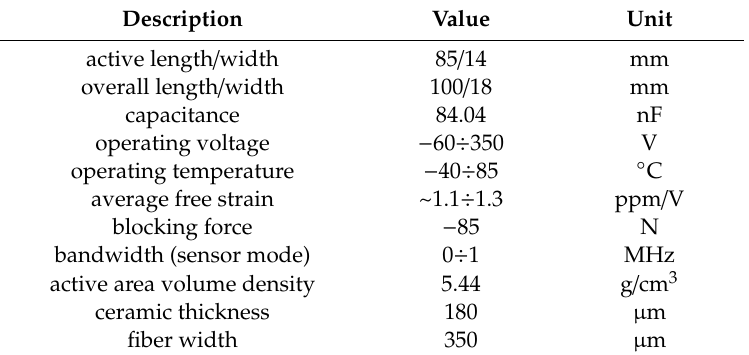
Table 3. Properties of MFC element type